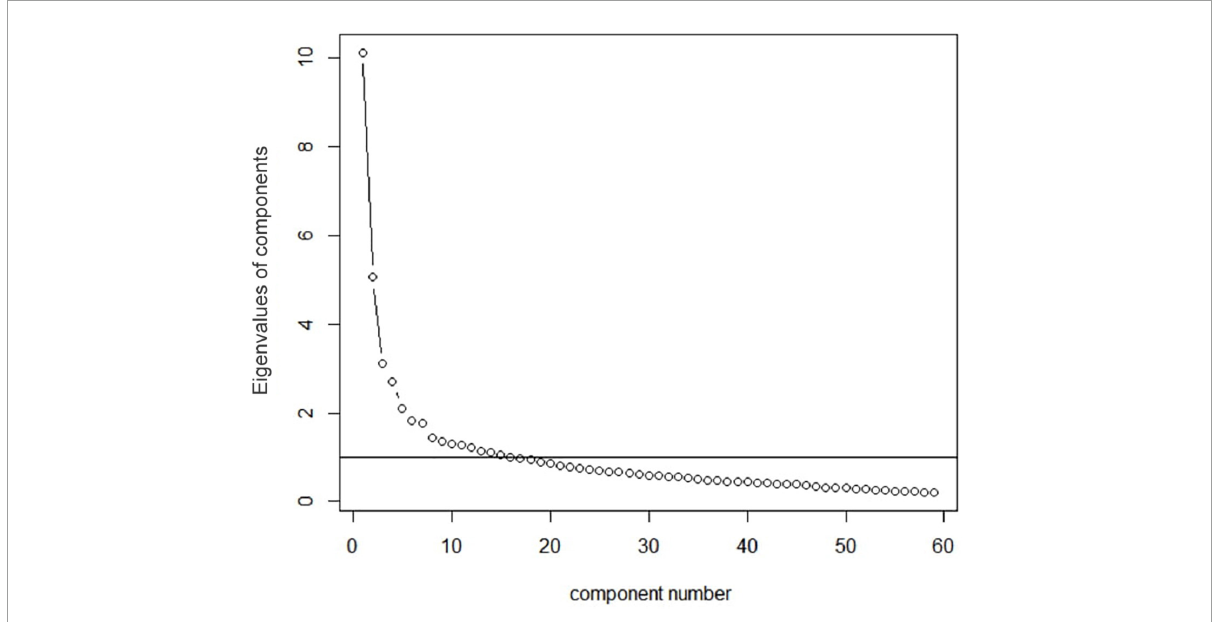
FIGURE2 Scree plot of factor